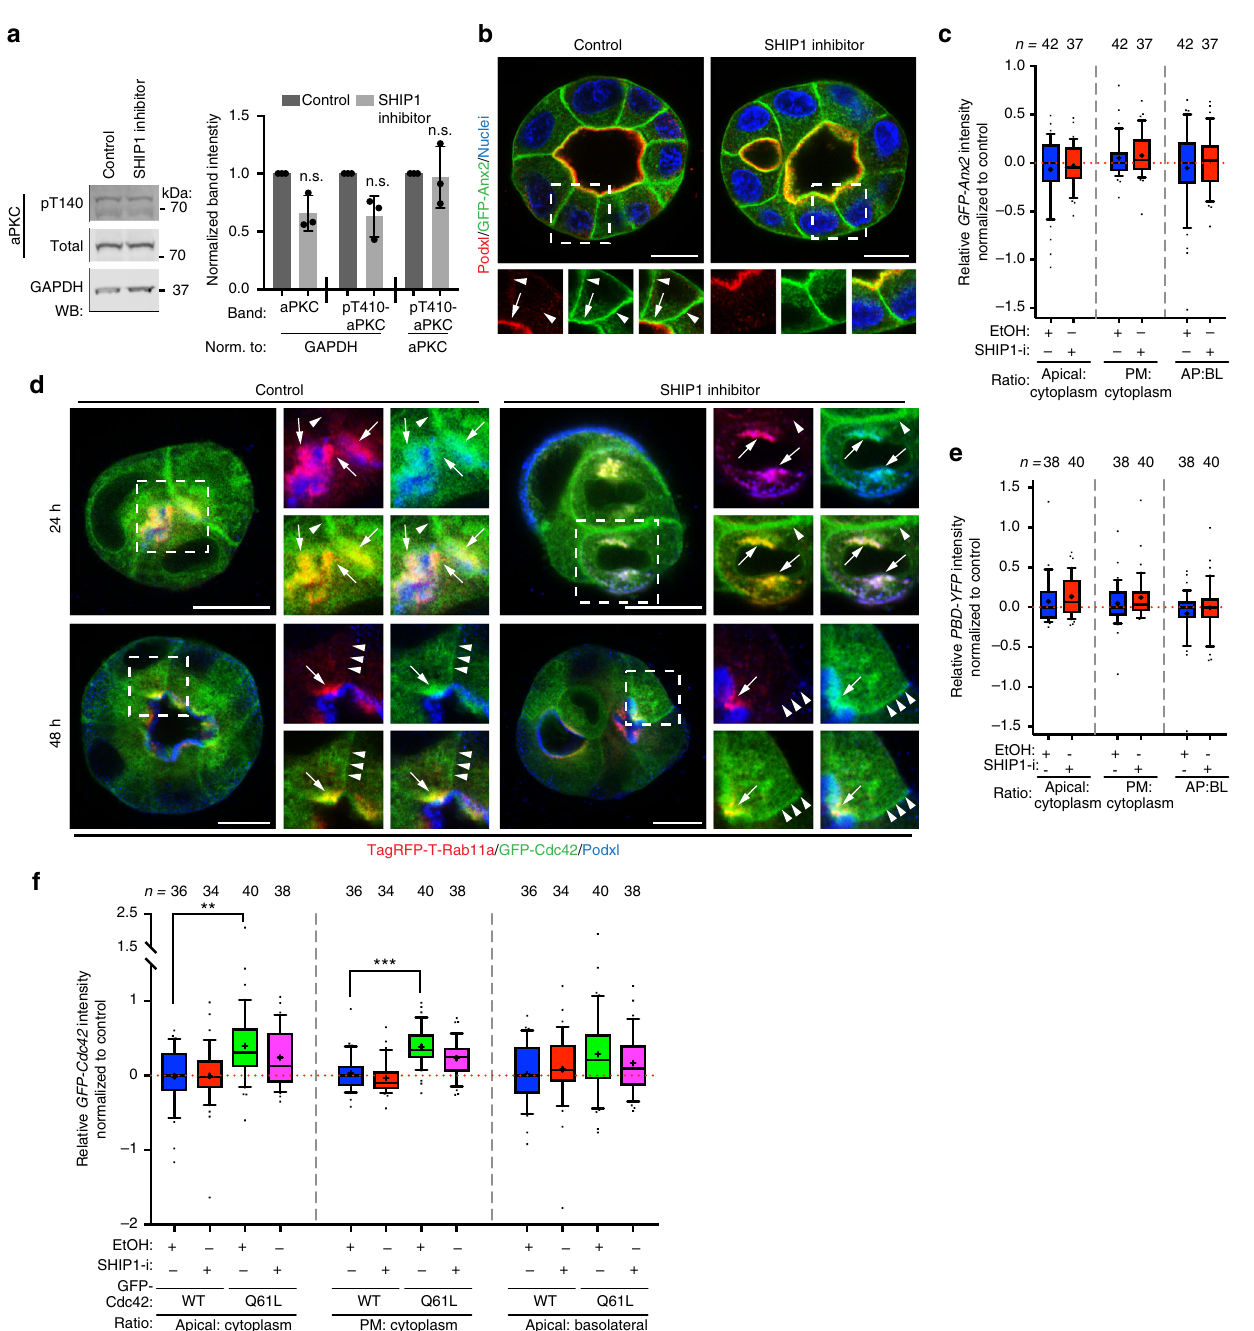
Fig. 8 The apical Par complex is PI(3,4)P 2 -independent. a Left, total cell lysates of 3D MDCK cysts upon treatment with SHIP1 inhibitor or ethanol as control, western blotted for total or phospho-aPKC (pT410), and GAPDH. Right, quantitation of normalized band intensity across experimental replicates. Mean± s.d., n = 3, P- value, Mann – Whitney test. n.s. stands for non-signi fi cant. b Forty-eight hours MDCK cyst stably overexpressing GFP-Anx2 (green) treated with either ethanol (control) or SHIP1 inhibitor, stained for Podxl (red) and nuclei (blue). White arrows, apical membrane. White arrowheads, lateral domain. Scale bars, 10 µ m. c Quantitation of apical to cytoplasm (left), plasma membrane to cytoplasm (center) or apical to basolateral (right) GFP- Anx2 relative intensity in control (Ethanol, EtOH) or SHIP1-inhibited (SHIP1-i) conditions. All conditions are Log2 ratios normalized to control cysts. Box-and-whiskers: 10 – 90 percentile; + , mean; dots, outliers; midline, median; boundaries, quartiles. n ≥ 37 cysts per condition, assessed from one experiment. d Twenty-hour or 48 h MDCK cysts stably co-overexpressing GFP-Cdc42 (green) and TagRFPT-Rab11a (red) in control (EtOH) or SHIP1-inhibited conditions, stained for Podxl (blue). White arrows, Rab11a/Cdc42 co-localization. White arrowheads, basolateral. Scale bars, 10 µ m. e , f Quantitation of relative apical to cytoplasm (left), plasma membrane to cytoplasm (center), or apical to basolateral (right) intensity of MDCK cysts stably expressing either PBD-YFP e or GFP-Cdc42 (WT or Q61L mutant, f ) in control (EtOH) or SHIP1-inhibited (SHIP1-i) conditions. All conditions are Log2 ratios normalized to control cysts. Box-and-whiskers: 10 – 90 percentile; + , mean; dots, outliers; midline, median; boundaries, quartiles. n ≥ 34 cysts per condition, assessed from one experiment. P- value, Mann – Whitney test. ** P ≤ 0.005, *** P ≤